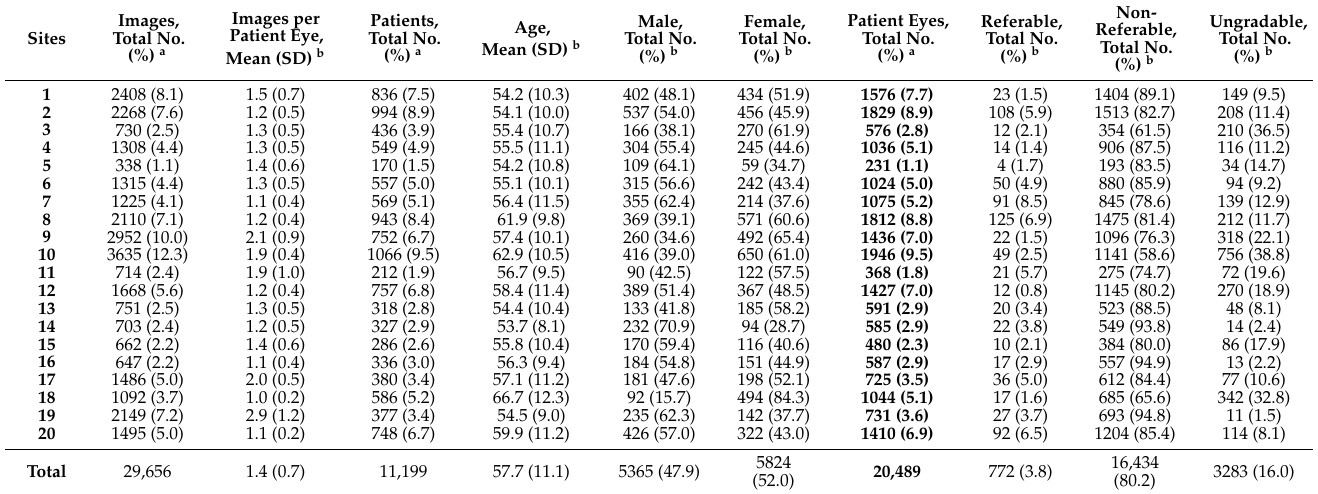
Table 1. Patient demographics for each site and patient eye grade